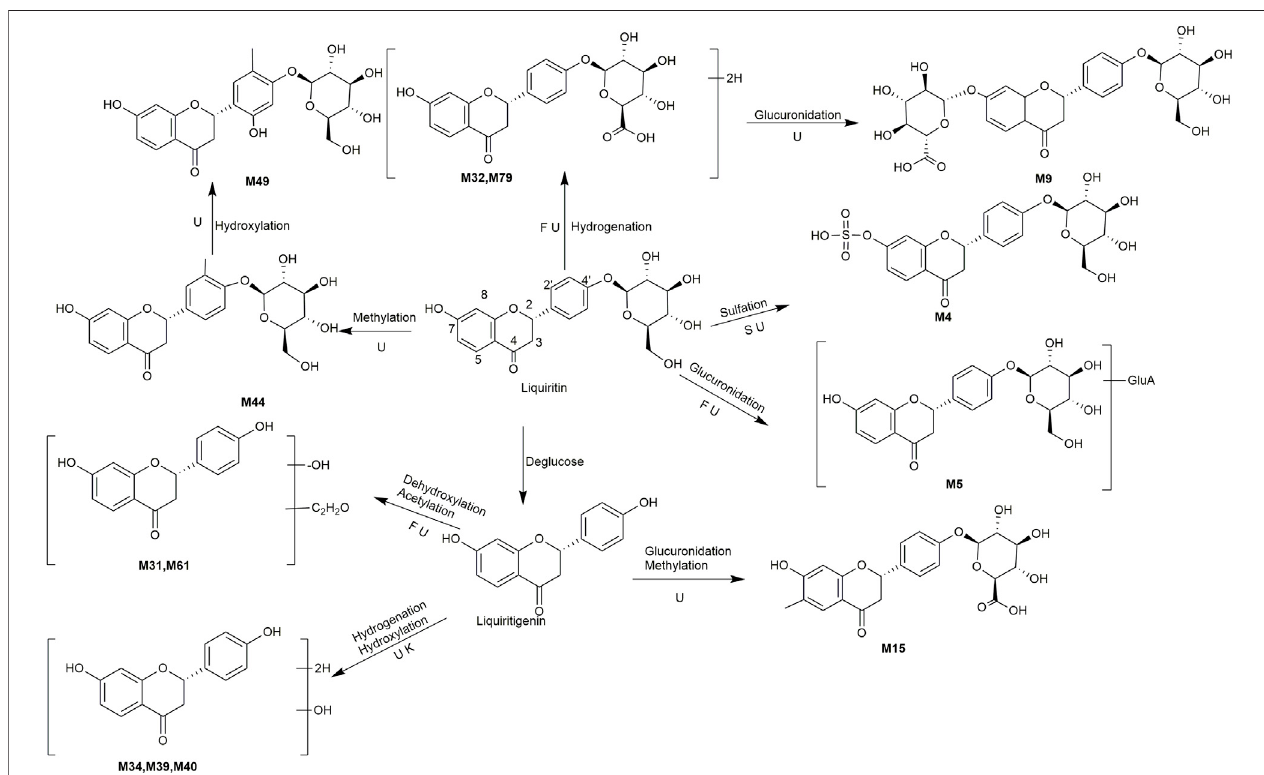
FIGURE3| Theproposedmetabolicpathwayofliquiritin-relatedmetabolitesinratsbiosamples.(S,H,FandUrepresentedserum,heart,fecesandurinesamples, respectively).